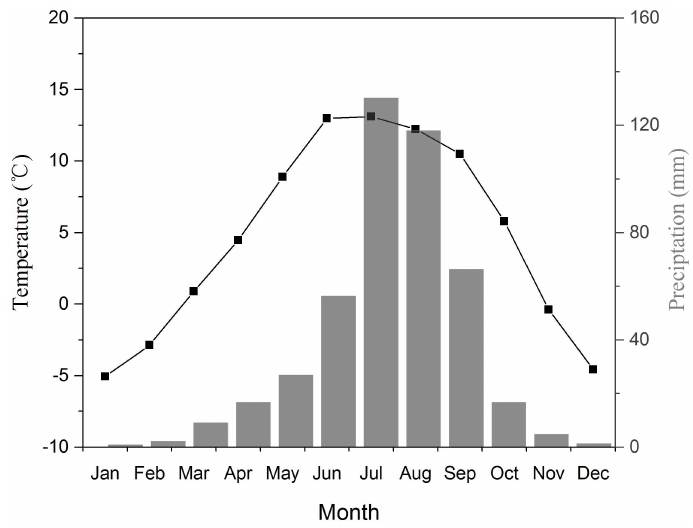
Fig 1. Mean monthly air temperature and monthly total precipitation for the period 1978–2010from the Zuogong meteorological station.